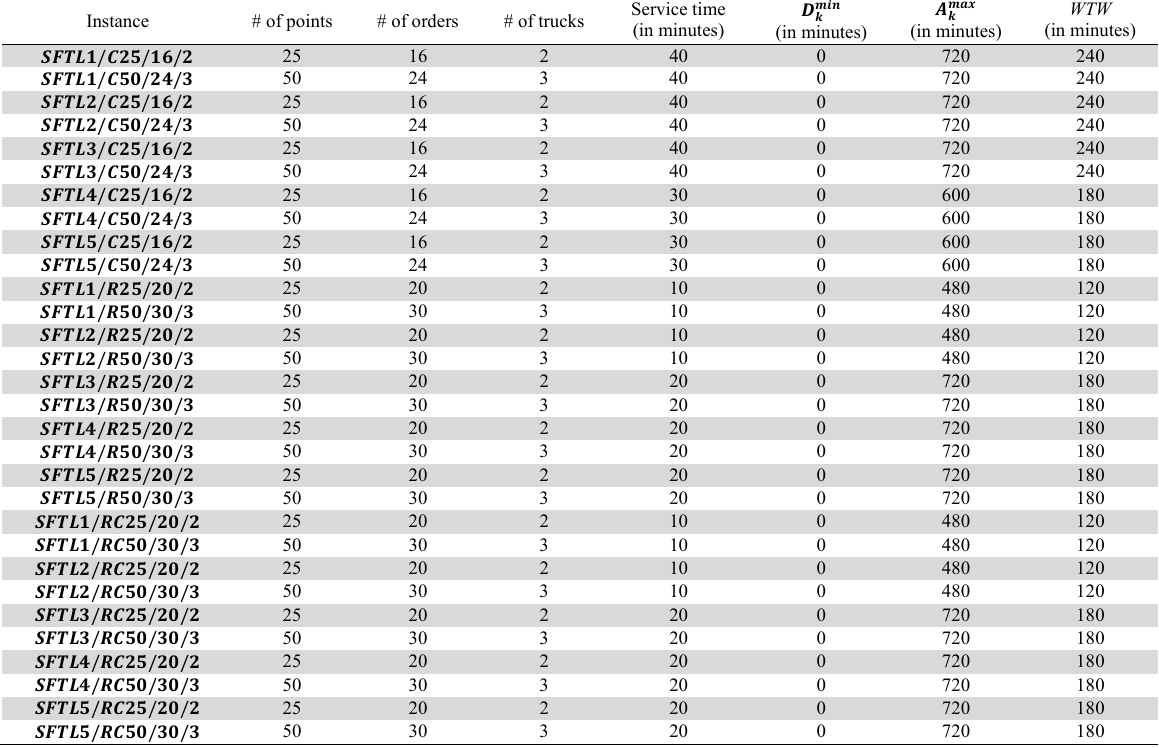
Main characteristics of the generated